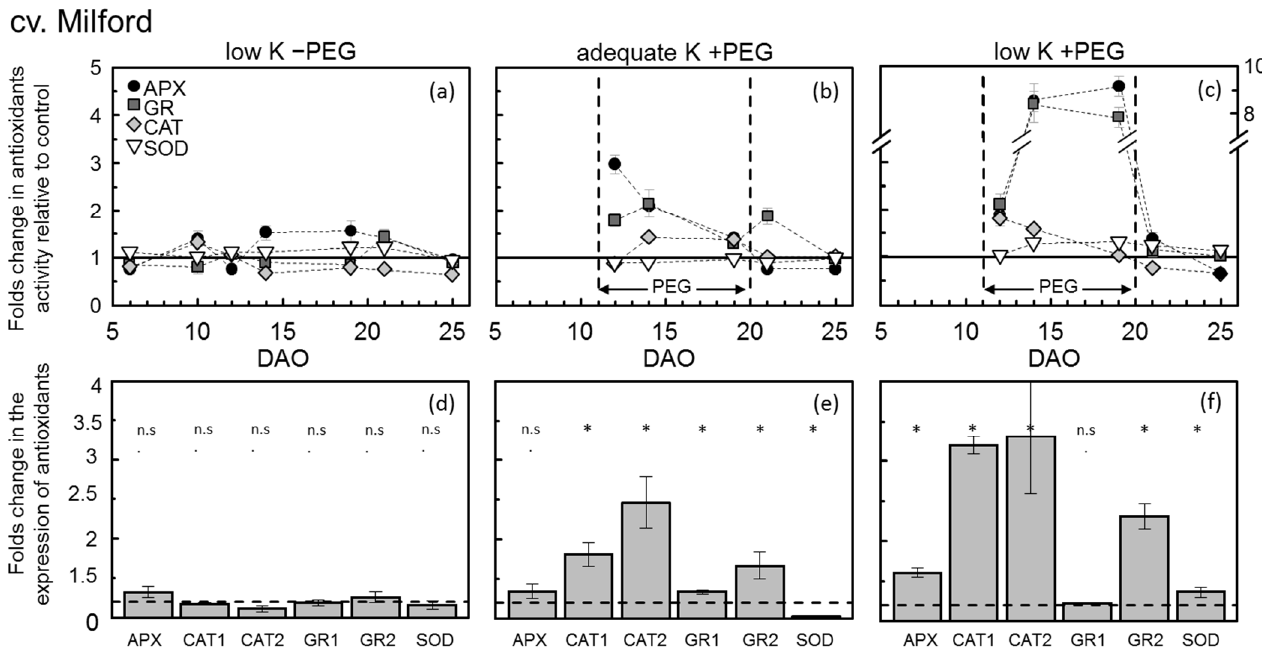
Figure 3. Temporal course of antioxidant (APX, GR, CAT, SOD) activities in fully expanded young leaves (above) 5–25 days after the onset of K treatment (DAO) and the relative gene expression at 14 DAO (below) of barley (cv. Milford) grown in a nutrient solution under two levels of K supply (adequate K: 0.8 mM K+; low K 0.04 mM K+) without and with a PEG-induced water deficit ( − PEG; +PEG). On each sampling day, values of the treatments “low K − PEG”, “adequate K +PEG” and “low K +PEG” are expressed as fold changes in comparison to control (“adequate K − PEG” = 10%, represented by the solid horizontal line in each plot). Symbols represent means ± SE ( n = 6). In the gene expression plots, the dashed horizontal lines similarly represent the control treatment (“adequate K − PEG” = 1), and the bars reflect the fold changes of the selected genes in comparison to control. GR1 and GR2 represent chloroplastic and cytosolic glutathione reductase, respectively. SOD; chloroplastic superoxide dismutase, CAT1 and CAT2; two catalase gene copies and APX; peroxisome type ascorbate peroxidase. Each single combination of K-level × PEG-level × barley-variety for antioxidant activity is shown by the letters ( a – c ) and the exact same combination for gene expression is represented by letters ( d – f ). The significant expressions are shown with * ( p < 0.05). All samples were taken at 13:00